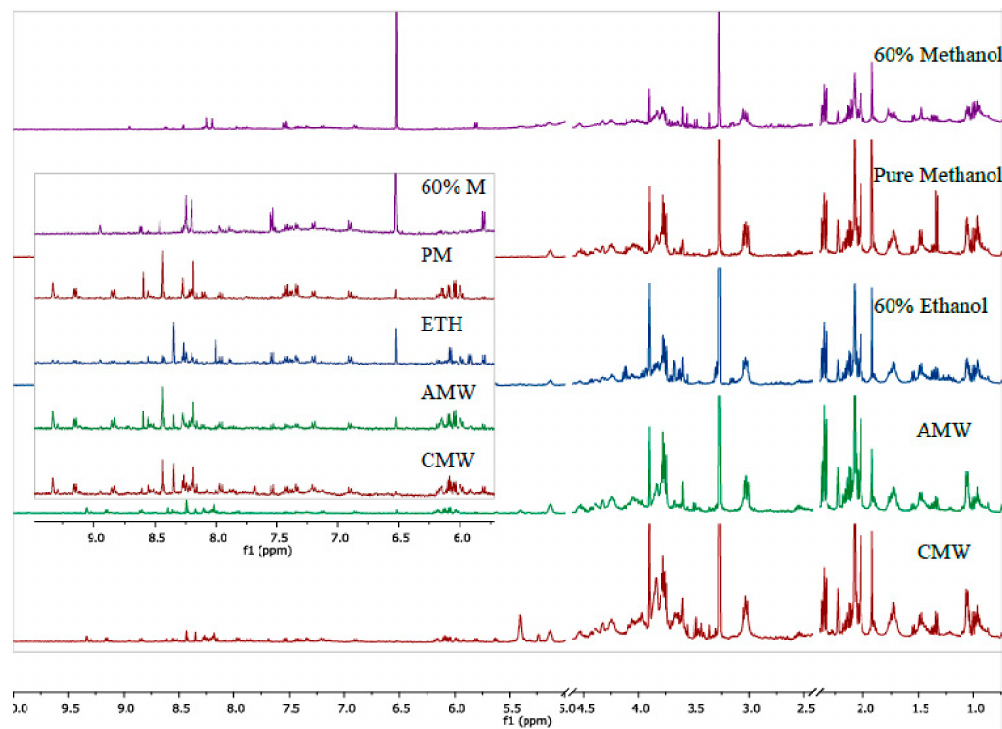
Figure 1. Representative 1 H-NMR spectra of the polar fraction of the metabolome of Yersinia enterocolitica extracted using the tested extraction methods: 60% methanol, pure methanol (PM), 60% ethanol (ETH), acetonitrile/methanol/water (AMW; 2:2:1), and chloroform/methanol/water (CMW; 2:1:1).